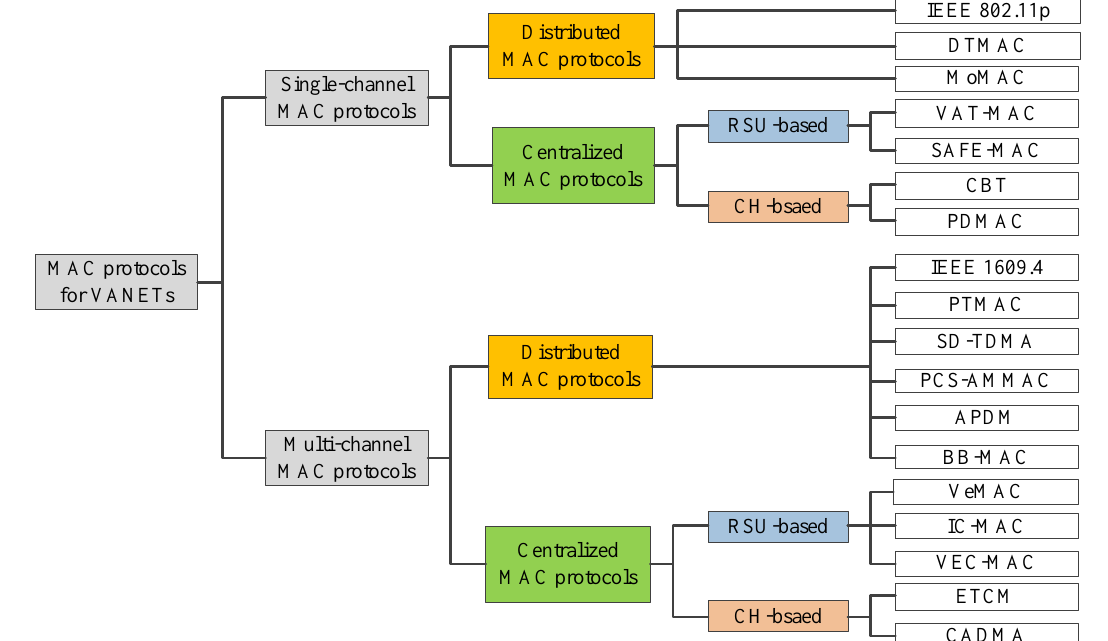
Figure 2. Classification of MAC protocols for VANETs.